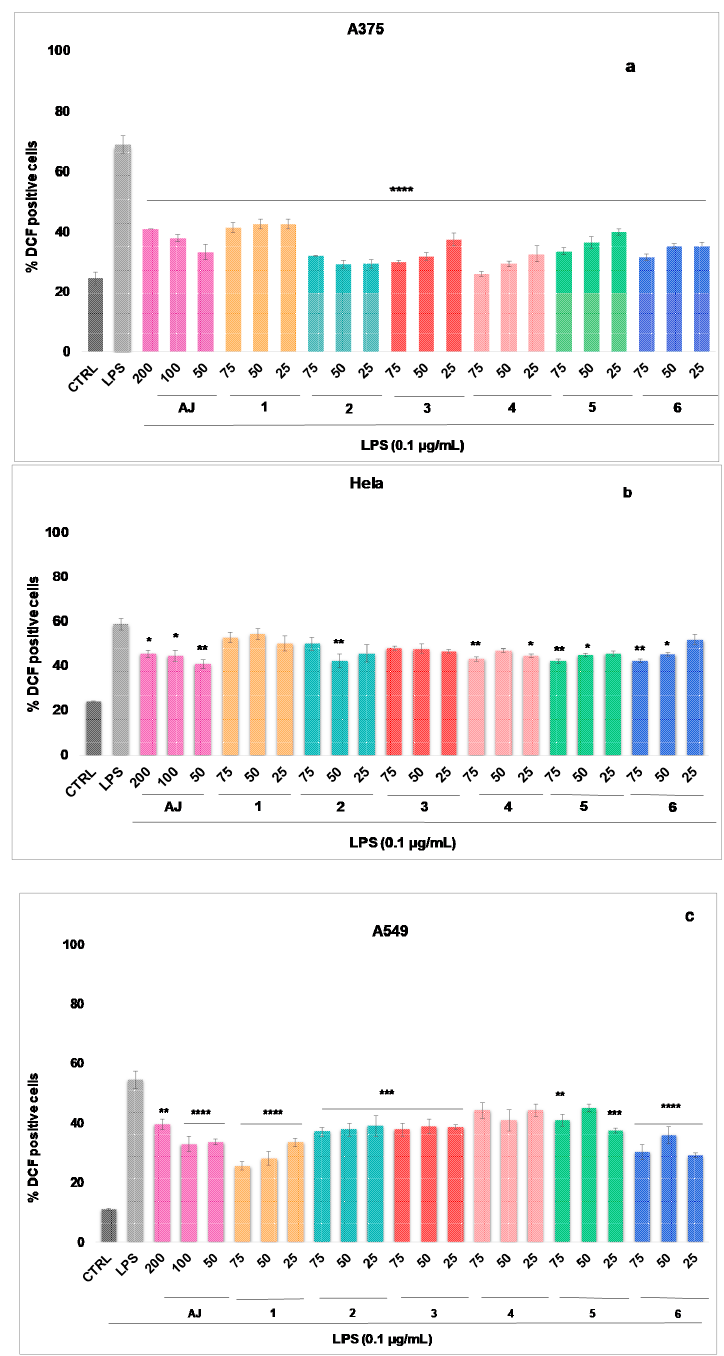
Figure 2. Reactive oxygen species (ROS) formation was evaluated through the probe 2 ′ ,7 ′ dichlorofluorescein diacetate (H 2 DCF-DA) in A375 ( a ), HeLa ( b ), and A549 ( c ) cells. AJ (200–50 µg/mL) and pure compounds ( 1 – 6 ) (75–25 µg/mL) were added for 1h and then for further 24 h exposed to lipopolysaccharides from Escherichia coli (LPS; 0.1 µg/mL). ROS production was expressed as mean ± standard deviation of the percentage of 2 ′ -7 ′ -dichlorofluorescein (DCF) positive cells of at least three independent experiments each performed in triplicate. Data were analyzed by Student’s t -test. * p < 0.05, ** p < 0.005, and *** p < 0.001 vs. LPS at the same experimental conditions.